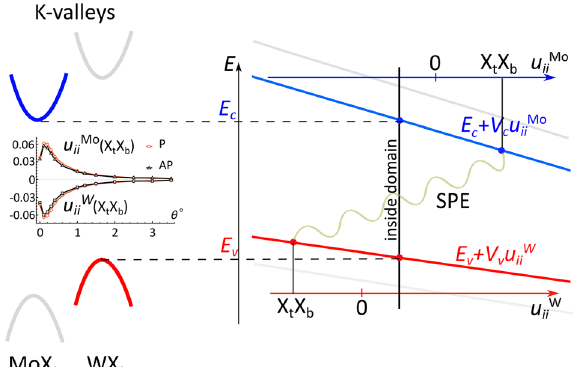
Fig. 1 Variation of K-valley conduction/valence, E c / v , band edges in MoX 2 (blue) and WX 2 (red) monolayers under hydrostatic strain with alignment of the bands corresponding to lattice-matched WX 2 /MoX 2 heterobilayers. The vertical black solid line shows the value of hydrostatic strain of individual layers inside domains. These values are opposite in sign with respect to those in X t X b nodes, leading to formation of localized electron and hole states in self- organized QDs, which are suitable for SPE (wavy line). Inset shows twist angle dependence of hydrostatic components of strain in MoX 2 and WX 2 layers in X t X b nodes of